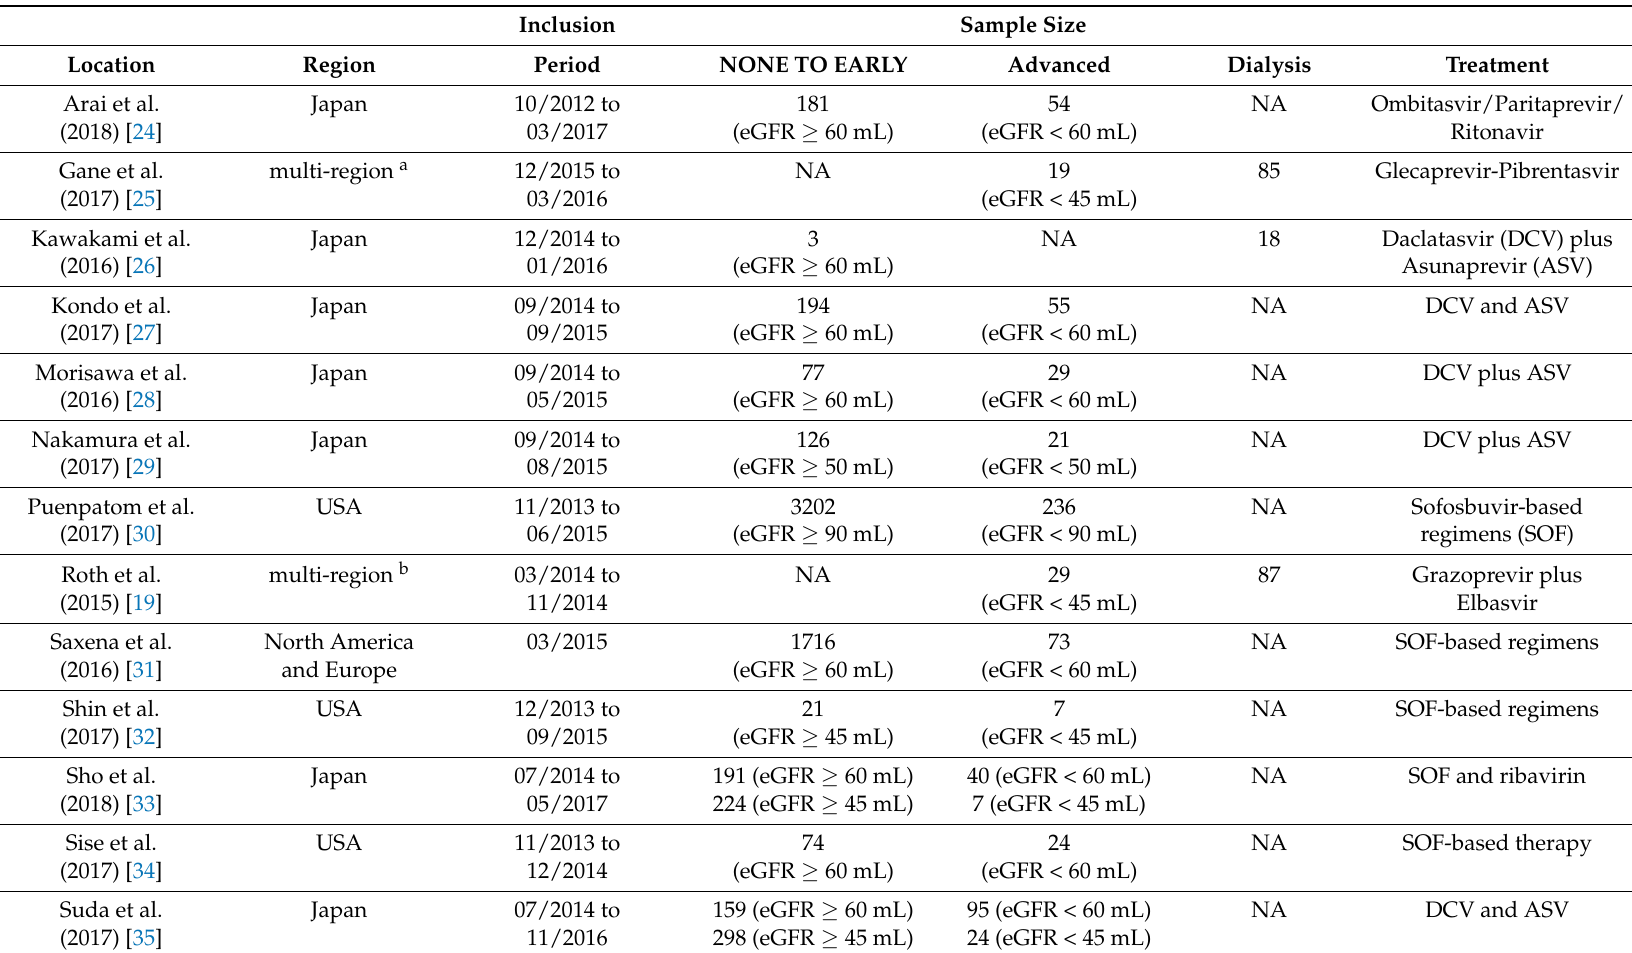
Table 1. (A) Characteristics of the included studies. (B) Characteristics of population and